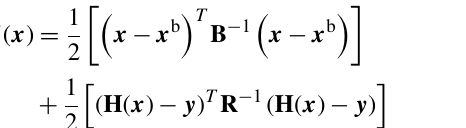
Figure 1. The horizontal WRF-CMAQ modelling domain (shown using lighter colours) based on the Lambert conformal